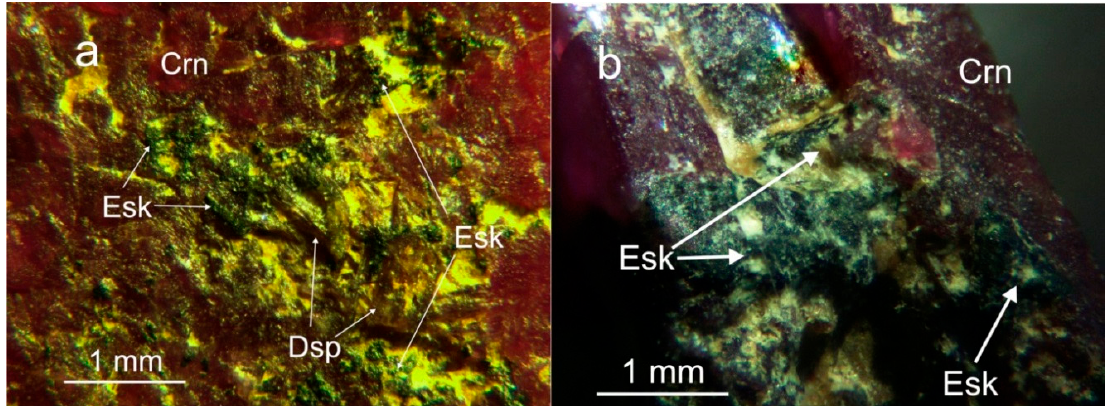
Figure 2. Eskolaite (Esk) and diaspore (Dsp) on the ( a ) pinacoidal and ( b ) rhombohedral crystal faces of the prograde stage ruby (Crn).